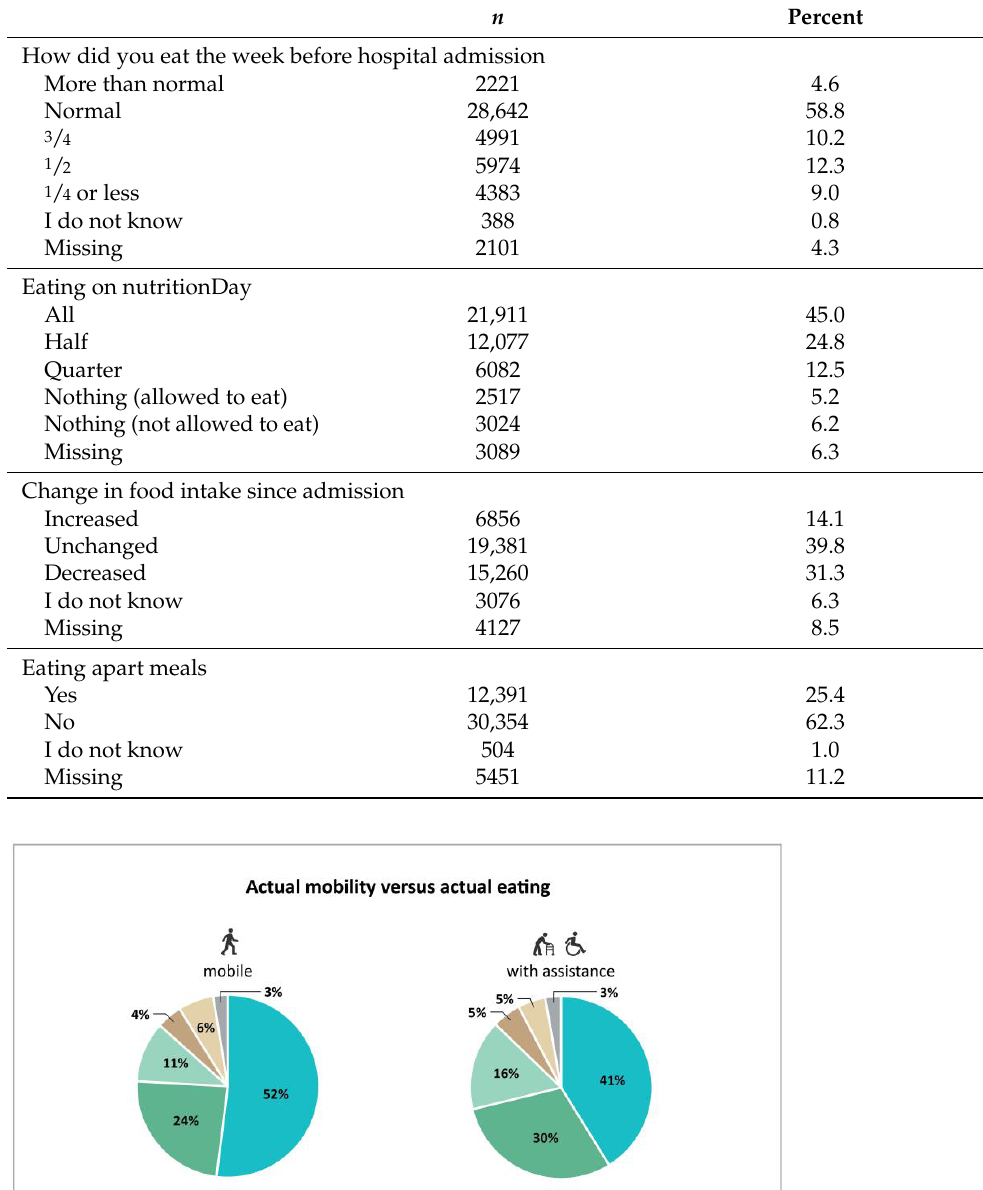
Table 4. Eating before hospital admission, at nutritionDay, and self-reported change in nutrient intake ( n = 48,700).